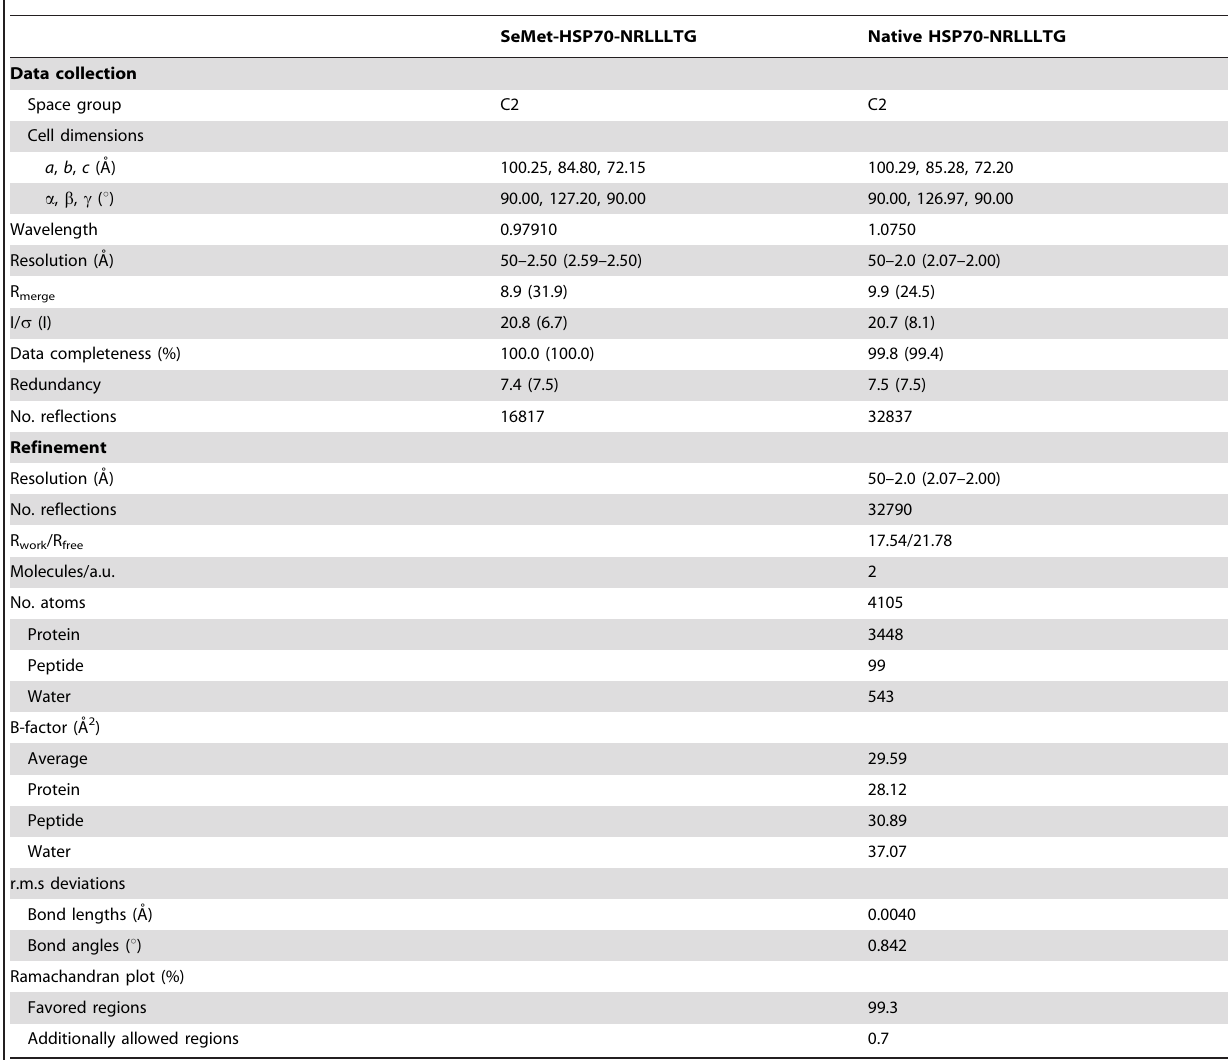
Table 1. Data Collection and Refinement